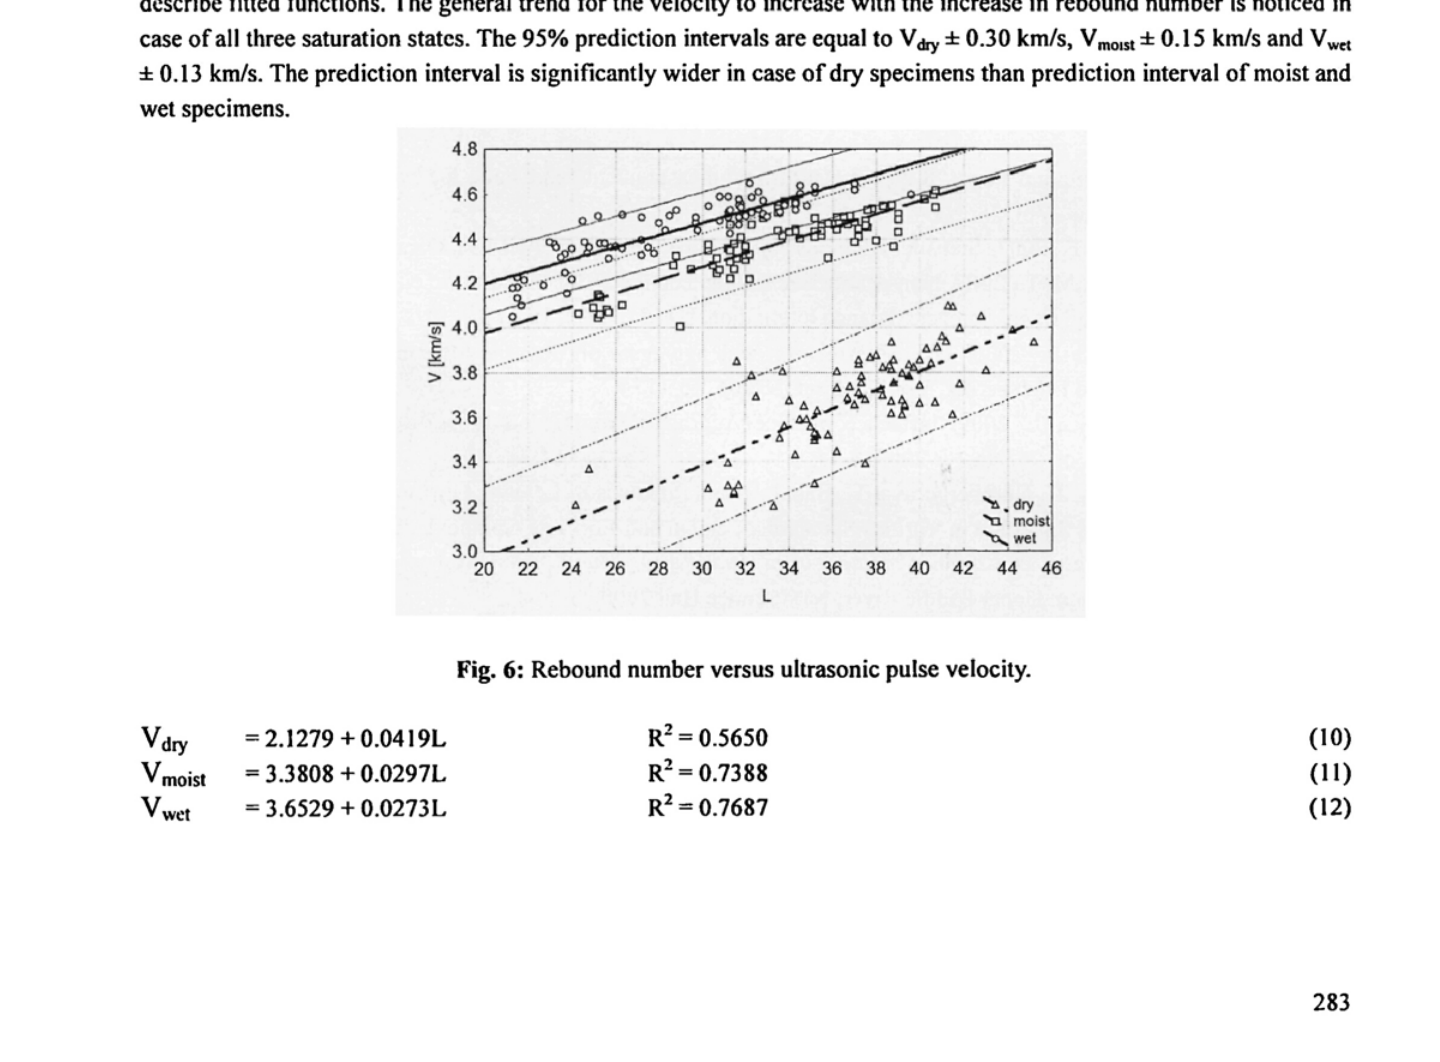
Fig. 6: Rebound number versus ultrasonic pulse